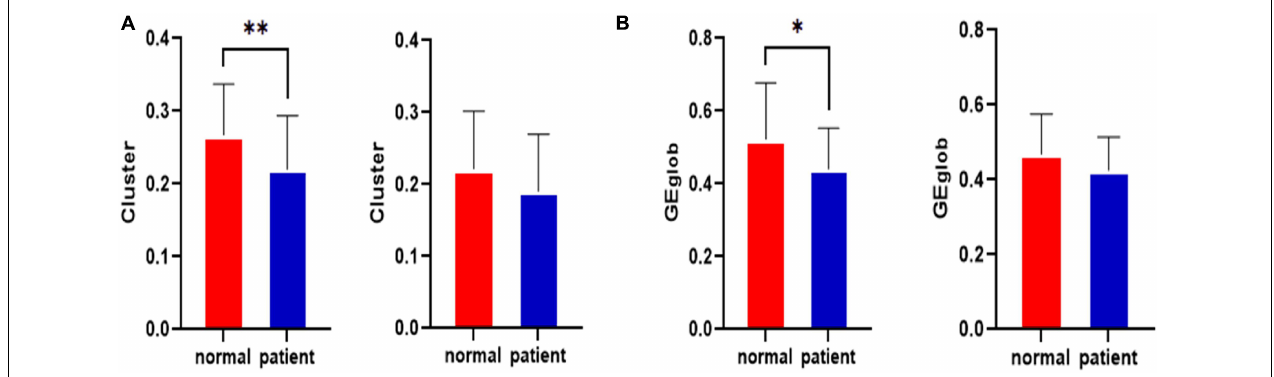
FIGURE 2 | Statistical clustering coefficient and global efficiency results for the left middle cingulate gyrus before and after the attacks in the healthy control group and the JME group. (A) Clustering coefficient results. (B) Global efficiency results. ∗ p < 0.05, ∗∗ p < 0.01, FDR-corrected.